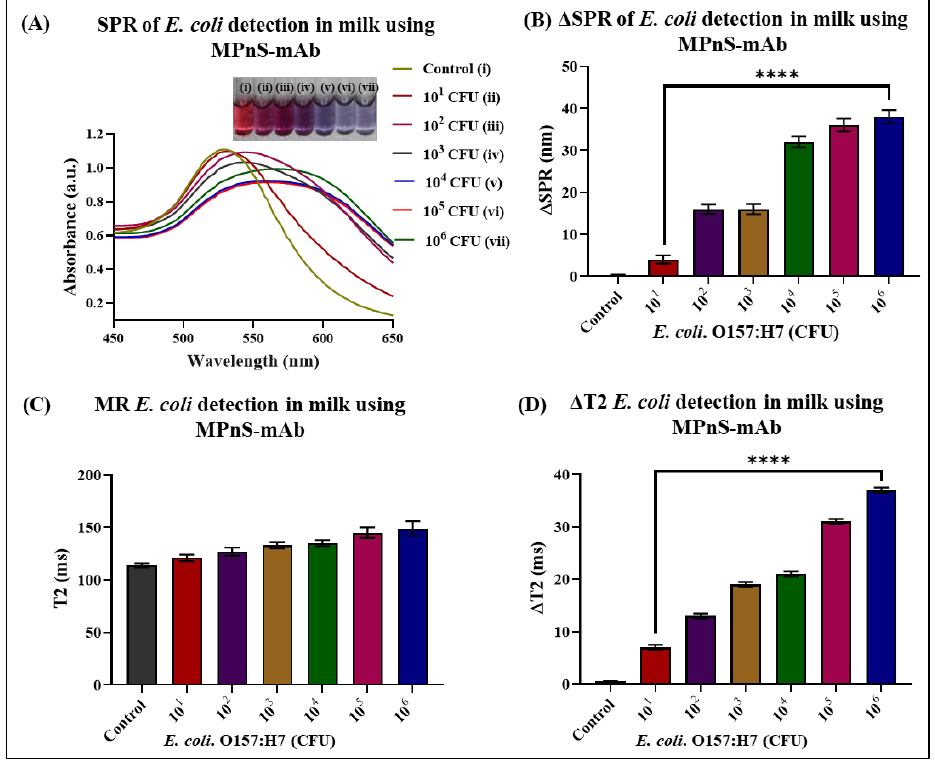
Figure 5. Evaluation of analytical sensitivity in complex media: ( A , B ) UV-Vis measurements, and ( C , D ) T2 MR experiments indicated the ability of E. coli O157:H7 detection in spiked milk. Statistically significant differences ( p < 0.0001 or ****) were observed when ΔSPR and ΔT2 data points in milk were compared at CFUs 10 1 and 10 6 .